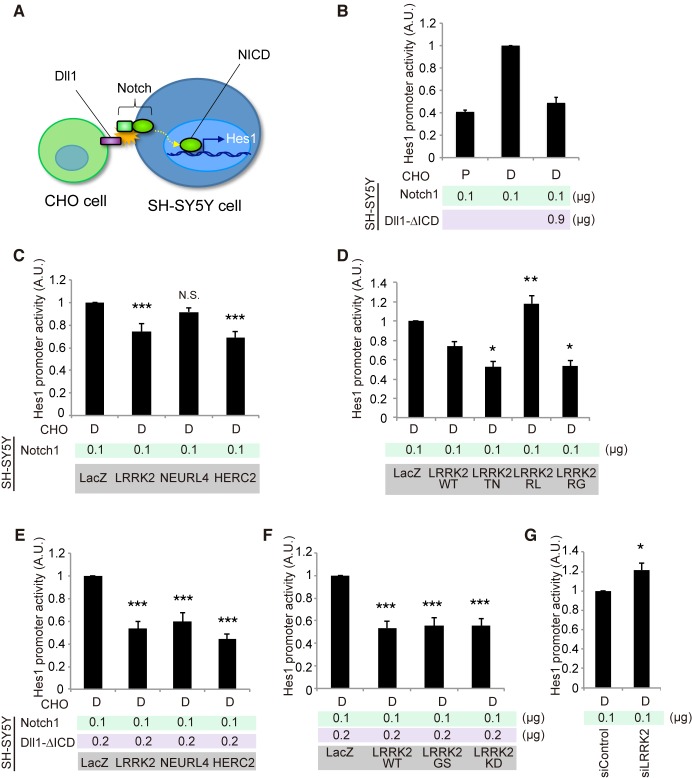
LRRK2, NEURL4 and HERC2 modulate Notch signal intensity in cultured cells.(A) Schematic of non-cell-autonomous Notch signaling and ‘cis-inhibition’ reconstituted in cultured cells. (B) Notch signal intensity assessed by the Hes1 promoter activity. SH-SY5Y cells were transfected with Hes1 reporter and Notch1 plasmids and control LacZ or Dll1-∆ICD plasmids. CHO cells stably expressing Dll1 (D) and parental CHO (P) cells were co-cultured as signal-sending and mock cells, respectively. (C) LRRK2 and HERC2 suppress Notch signal intensity. (D) LRRK2 ROC mutations affect the suppressive potency of Notch signaling. (E, F) ‘Weak cis-inhibition’ condition accentuates the apparent suppressive effects of LRRK2, NEURL4 and HERC2 on Notch signal intensity. (G) LRRK2 knockdown activates the Notch signal. (C, E, F) ***, p < 0.001; **, p < 0.01; N.S., not significant vs. LacZ and (D) **, p < 0.01; *, p < 0.05 vs. LRRK2 WT by one-way ANOVA. (G) *, p < 0.05 by Student’s t-test. The data represent the mean ± SE at least from three experiments performed in triplicate. KD, kinase-dead.